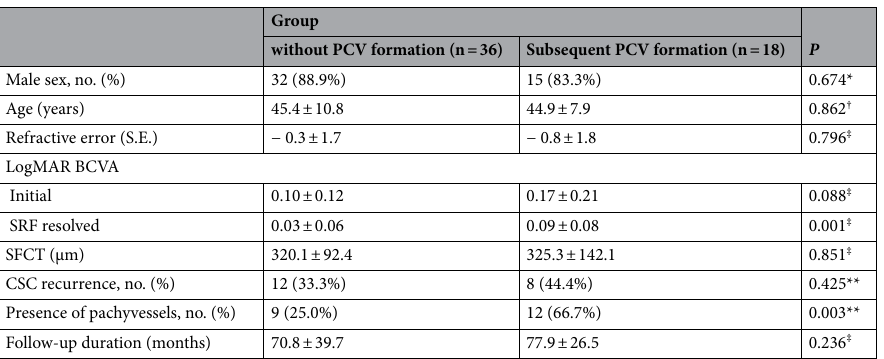
Table 1. Baseline characteristics of patients with chronic CSC in this study. Values are presented as mean ± SD. P value < 0.05 was considered statistically significant. *Fisher’s exact test; † independent t test; ‡ Mann–Whitney test; **Chi-square test; CSC, central serous chorioretinopathy; PCV, polypoidal choroidal vasculopathy; S.E., spherical equivalent; logMAR, logarithm of the minimal angle of resolution; SRF, subretinal fluid; SFCT, subfoveal choroidal thickness.